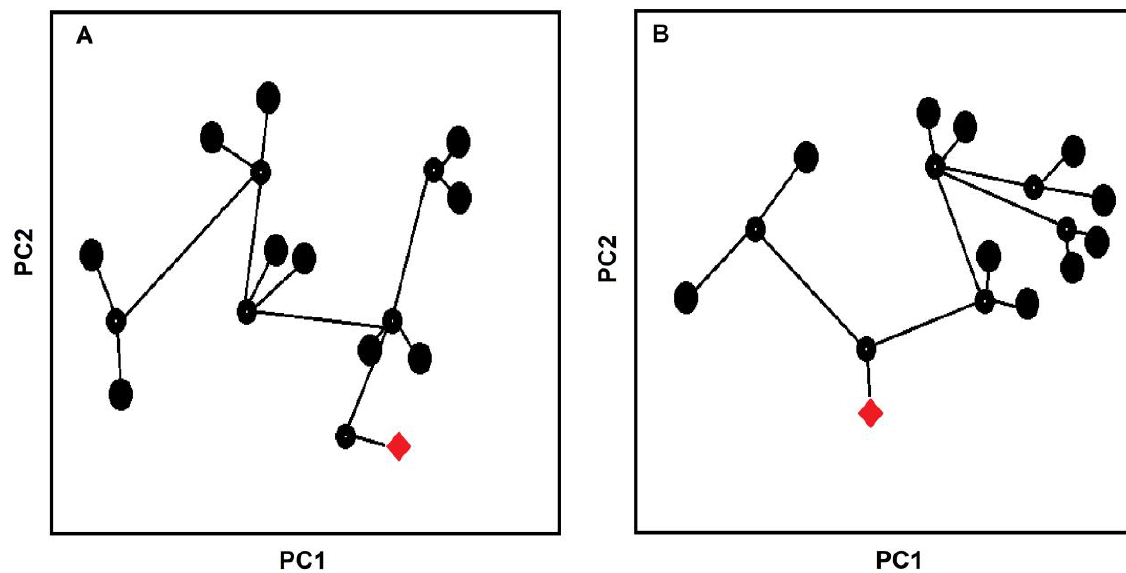
Figure 1. Two possible scenarios of morphospace filling in two dimensional axes from a Principal Component (PC) Analysis in a phylogenetic perspective. A) homogeneous, B)